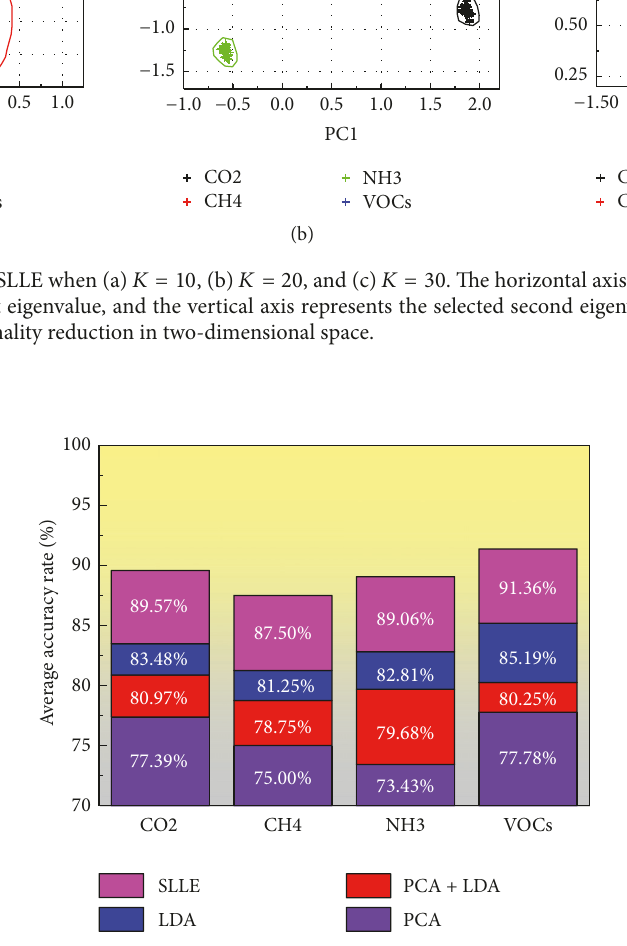
Figure 6: The results of the intuitive contrast average accuracy for the four sample gases. The horizontal axis represents the four sample gases, the vertical axis represents the accuracy of the recognition, and the four different colors represent the different algorithm results.